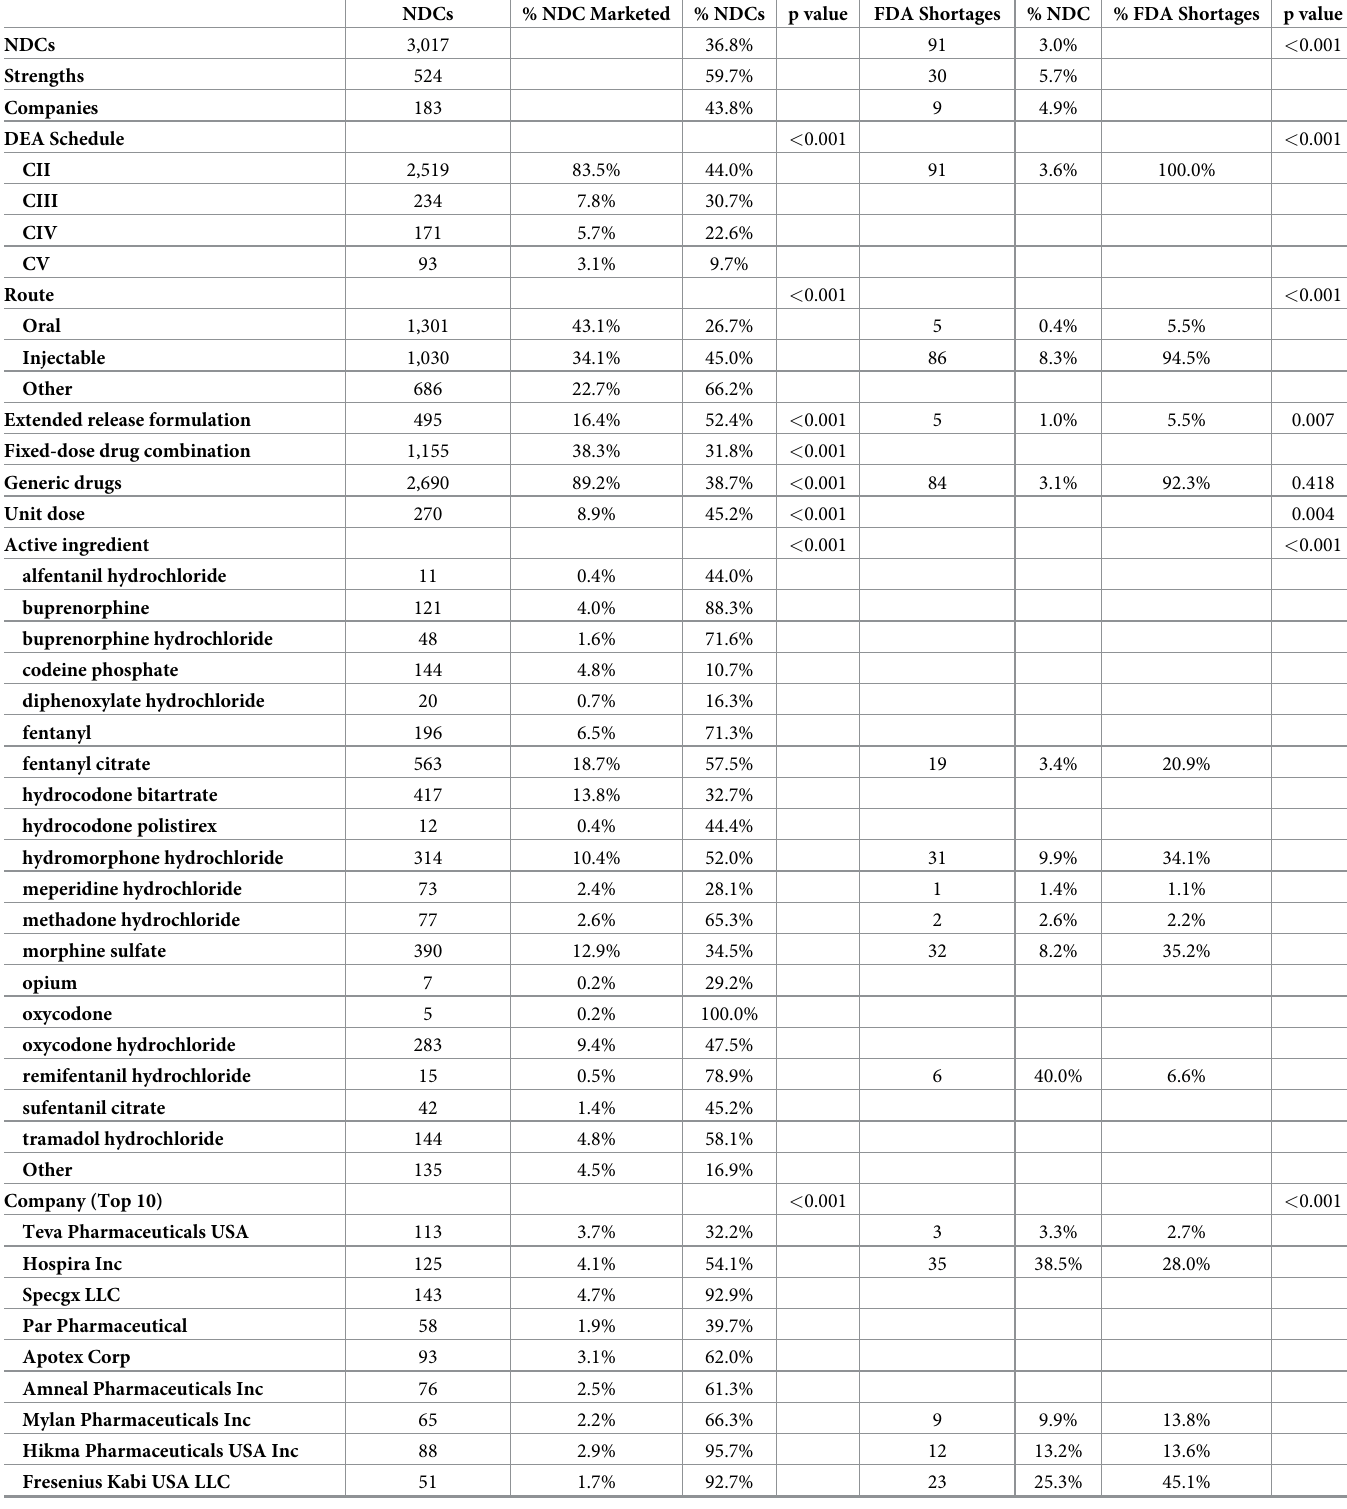
Table 2. Opioid NDCs marketed and shortages,